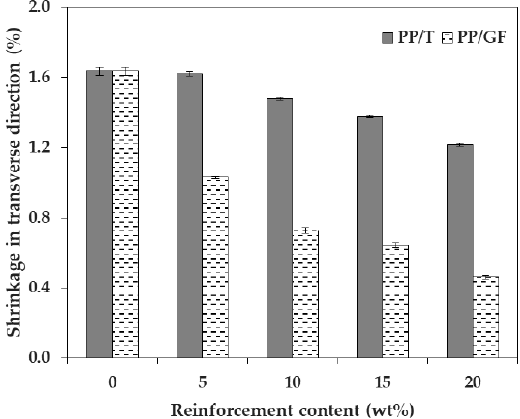
Figure 3. Shrinkage of PP/T and PP/GF in the transverse direction, depending on reinforcement type.